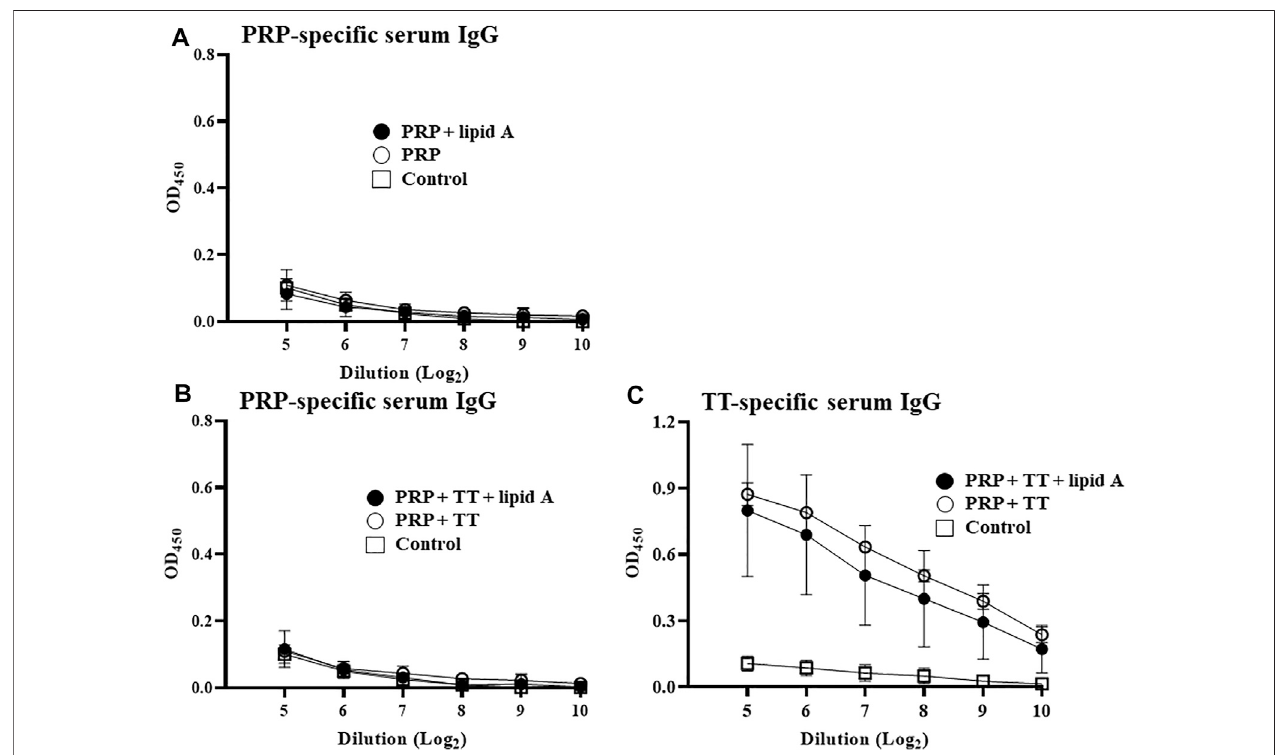
FIGURE 2 | Conjugation of PRP to TT carrier protein is essential for enhancement of PRP-speci fi c IgG production by Alcaligenes lipid A. (A) Mice were immunized subcutaneously with PBS (control group) or 0.01 μ g of unconjugated PRP with or without 1 μ g of Alcaligenes lipid A. (B) Mice were immunized subcutaneously with PBS (control group) or 0.01 μ g of unconjugated PRP plus 0.024 μ g of TT and with or without 1 μ g of Alcaligenes lipid A. Serum was collected 1 week after the fi nal immunization, and the level of PRP-speci fi c IgG was measured by ELISA (experimental group, n (cid:2) 5; control group, n (cid:2) 4). (C) Mice were immunized subcutaneously with PBS (control group) or 0.01 μ g of unconjugated PRP plus 0.024 μ g of TT and with or without 1 μ g of Alcaligenes lipid A. Serum was collected 1 week after the fi nal immunization, and the level of TT-speci fi c IgG was measured by ELISA (n (cid:2) 5/group). Data are representative of two independent experiments and are presented as mean ± 1 SD.